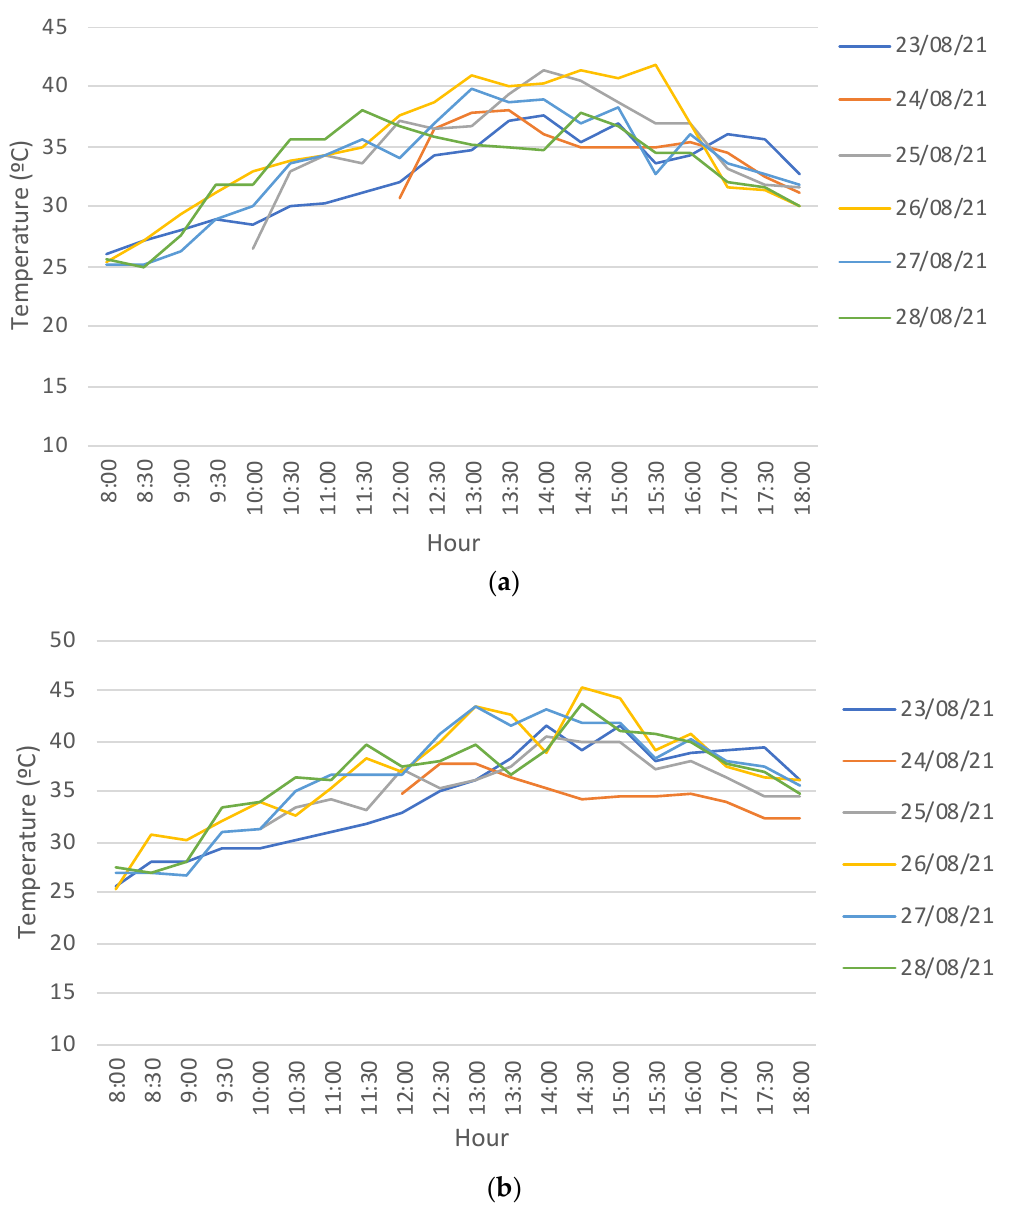
Figure 6. Temperature behavior in the control: ( a ) Water temperature and ( b ) Temperature of the control walls. The colors in the lines indicate the temperature of each monitored day.